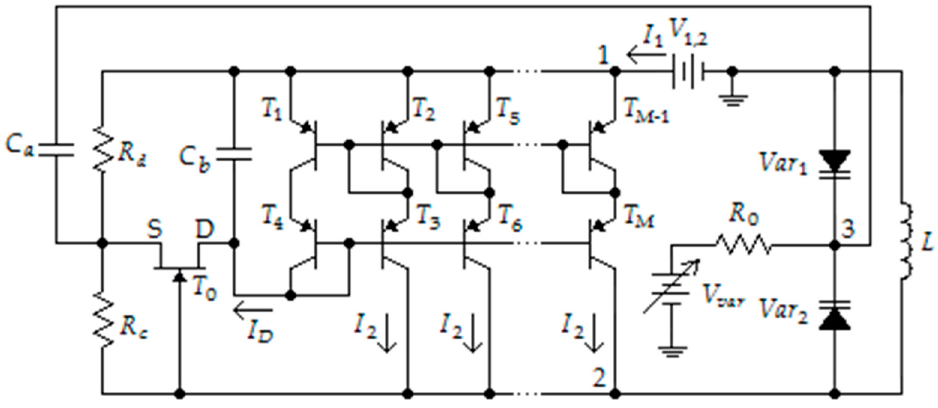
Figure 10. Voltage-controlled oscillator with multiple-output Wilson current mirror.